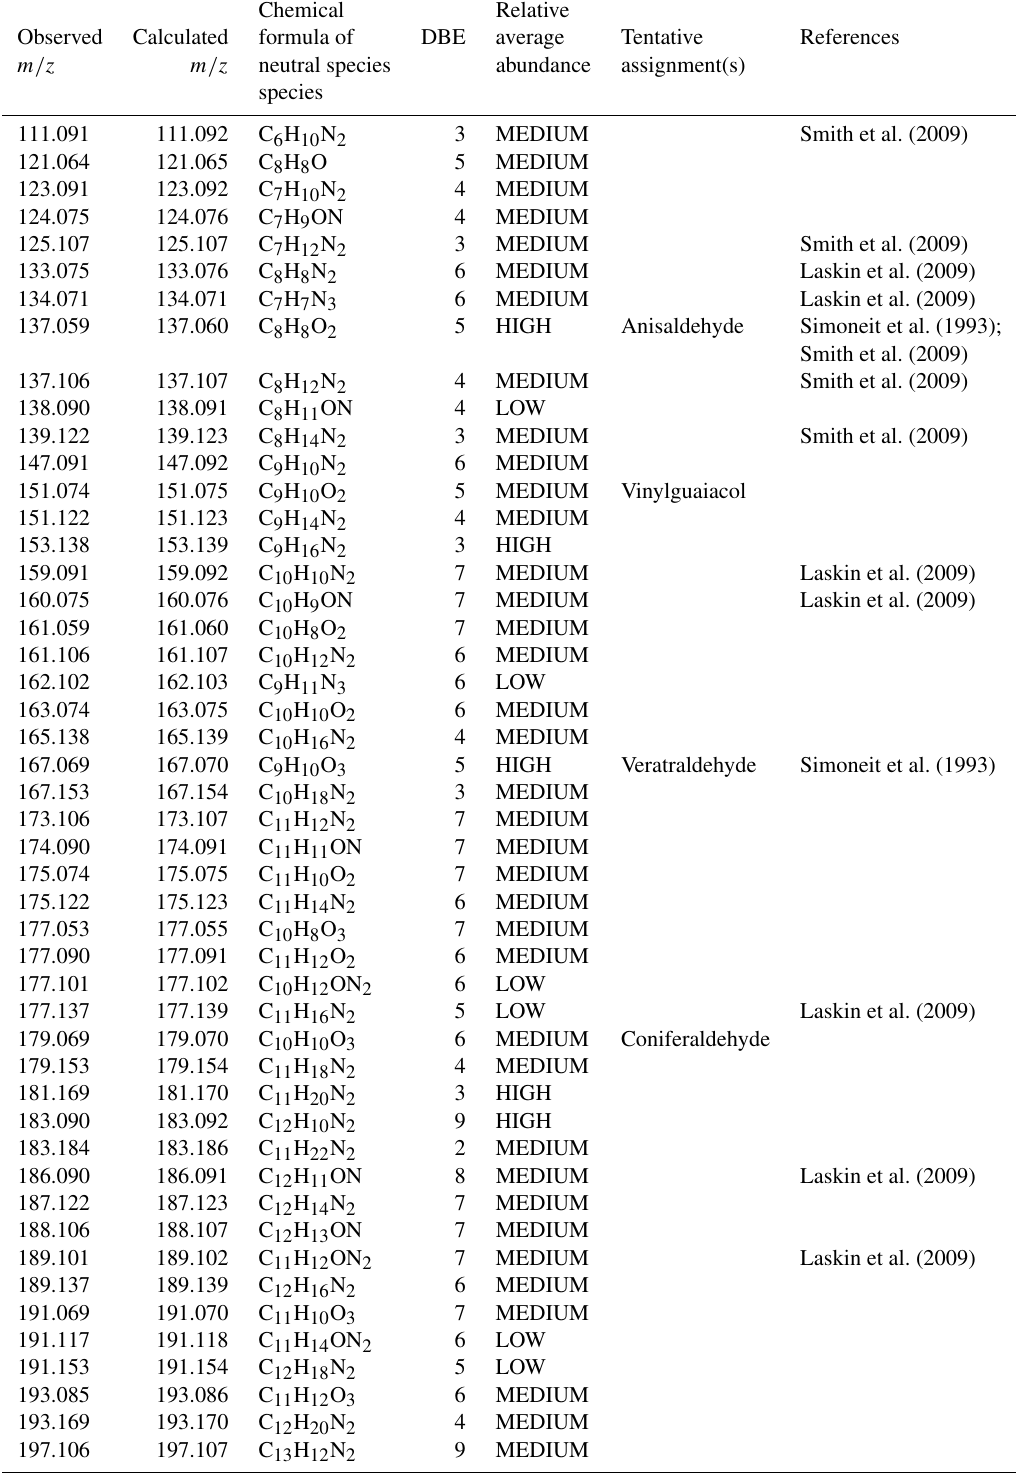
Table 1. List of common compounds found in all PM 2 . 5 samples regardless of fuel or stove type. Tentative molecular structure assignments are listed when the compound has previously been identified in the chemical biomass burning literature, supported by the references in the last column. Count-based, normalized peak abundances are designated LOW (<1%), MEDIUM (1–9.9%), and HIGH (10–100%). All species were detected as protonated